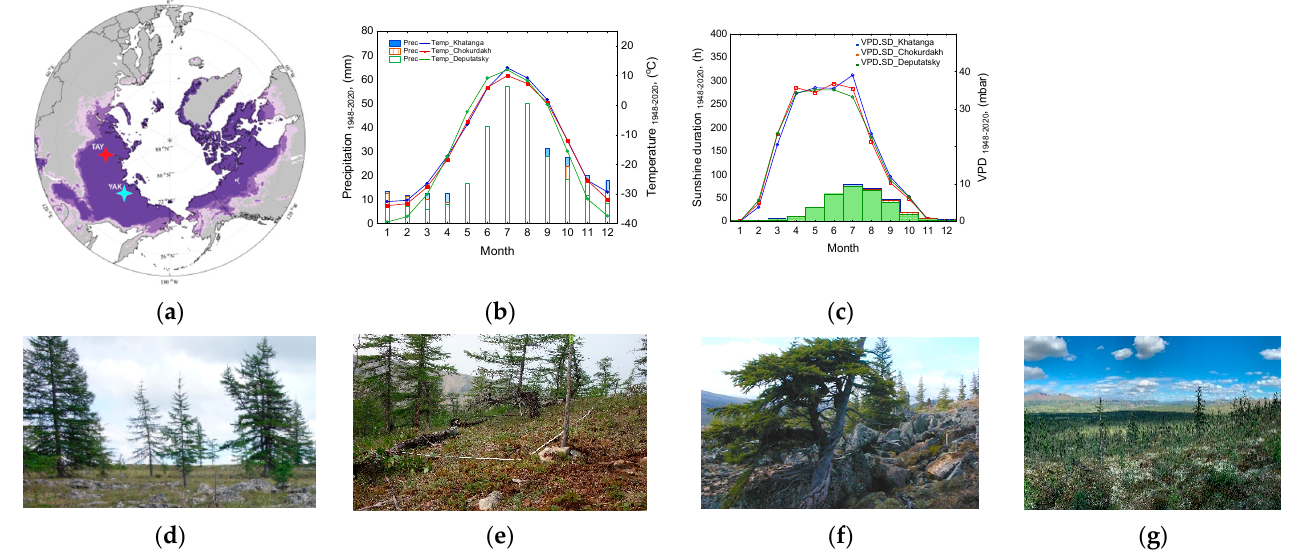
Figure 1. Map with the location of study sites in the Siberian subarctic Taimyr Peninsula (TAY, red star) and Yakutia (YAK, light blue star) in the zone of continuous permafrost. Map is modified after Churakova (Sidorova) et al. [39] ( a ). Modelled continuous and discontinuous permafrost zone distribution is marked in violet and light violet, respectively. Distribution of monthly air temperature and precipitation ( b ), and sunshine duration versus vapour pressure deficit (VPD) ( c ) obtained from the local Khatanga (TAY), Chokurdakh and Deputatsky (YAK) in comparison. Photos of trees from the study sites: Taimyr Peninsula (TAY) Kotuy ( d , e ), photos Alexander I. Bondarev; northeastern Yakutia (YAK), photo Mukhtar M. Naurzbaev ( f ) and Deputatsky, photo Alberto Arzac ( g ). The annual air temperature is − 14.0° C for YAK according to the local Chokurdakh and Deputatsky weather station data for the period from 1948 to 2021, and − 12.7° for TAY based on the Khatanga weather station. A low amount of annual precipitation is recorded for YAK (245 mm/year) and for TAY (275 mm/year) (Figure 1b). The average date of the